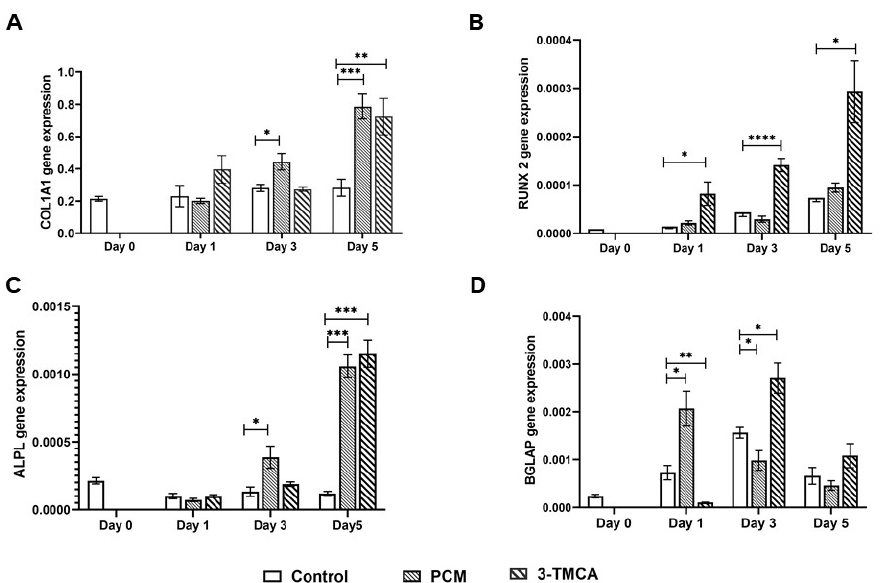
Figure 7. Comparison of the effects of PCM and the calcium-sensing receptor agonist 3-TMCA (1 µ M) on expression of osteogenic genes in MG63 osteoblastic cell line. ( A ) COL1A1 (collagen I), ( B ) RUNX-2, ( C ) ALPL (alkaline phosphatase), ( D ) BGLAP (osteocalcin). Results are shown normalised to GAPDH and the day 0 cell controls. * = p ≤ 0.05, ** = p ≤ 0.005, *** = p ≤ 0.0005, **** = p ≤ 0.00005.